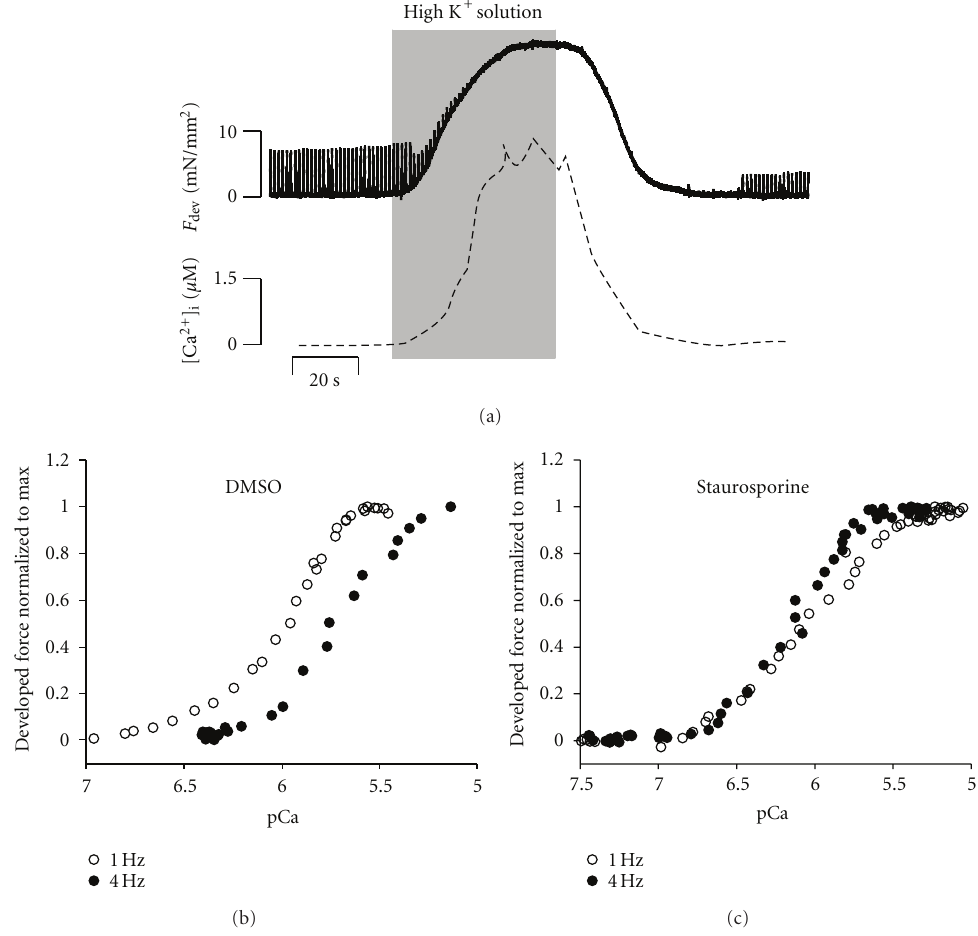
Figure 3: Figure 3 shows a representative acquisition and analysis of the force-calcium relationship. Panel (a) shows the chart of a potassium contracture. The trabecula in this example is twitching at 1Hz (top of panel) when the superfusate solution is rapidly switched from normal Krebs Henseleit solution to that with a higher potassium and lower sodium concentration. Diastolic calcium (lower panel) is measured by rapidly switching the excitation wavelength between 340 and 380nm. After the potassium solution is washed out, the contracture relaxes and the muscle recovers. Panels (b) and (c) show representative force pCa relationships obtained in trabeculae twitching at 1 or 4 Hz with vehicle (b) or staurosporine (c) in the superfusate